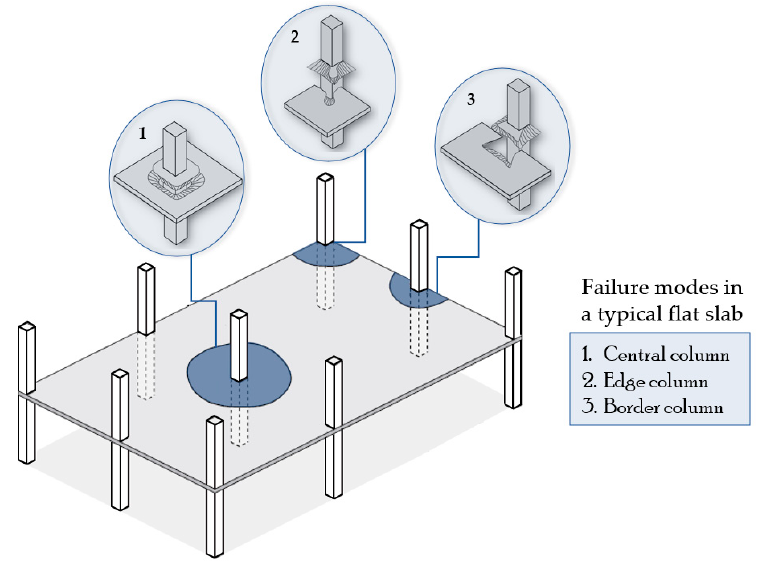
Figure 1. Punching phenomenon in reinforced concrete structures.